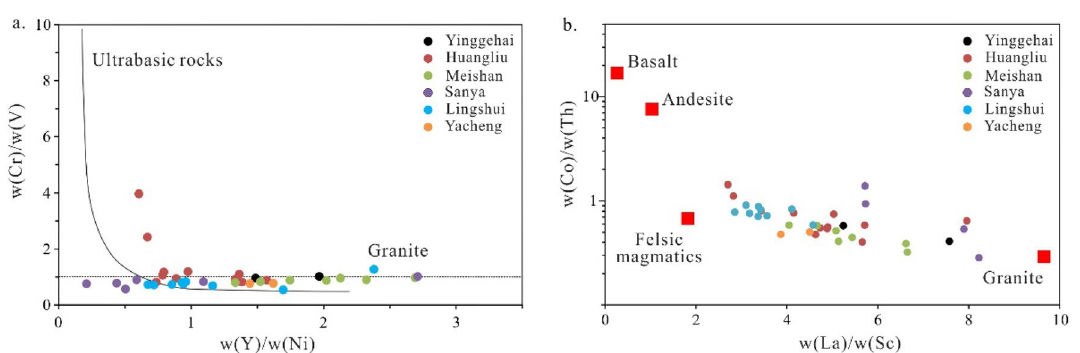
Figure 7. ( a ) Plot of SiO 2 vs K 2 O/Na 2 O and ( b ) ternary plot of Th-La-Sc to discriminate tectonic setting 49,53 .